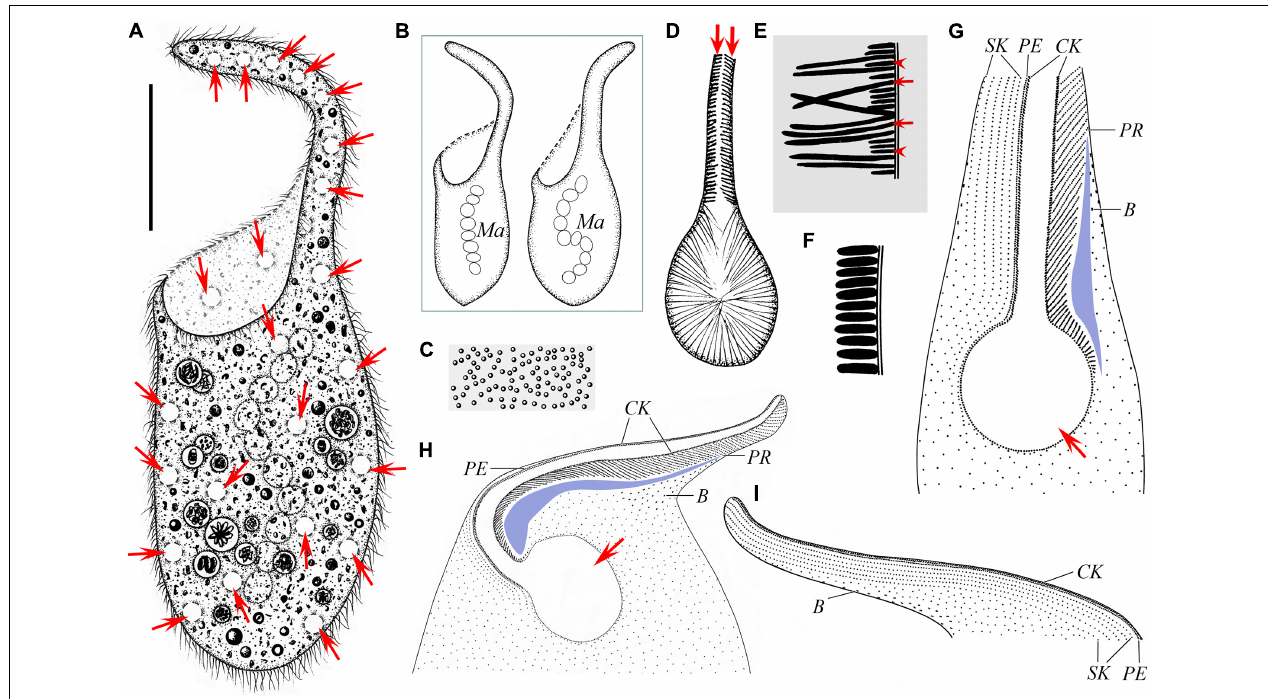
FIGURE 2 | Schematic drawings of Paradileptus elephantinus from life (A–F) and after protargol staining (G–I) . (A) Ventral view of a typical individual; arrows mark the contractile vacuoles. (B) Two individuals to show the different body shapes and distribution of macronuclear nodules. (C) Cortical granules underneath the pellicle. (D) Detail of oral apparatus, showing the oral opening, the basket supported by fibers, and the rod-shaped type II extrusomes (arrows) attached to the proboscis oral bulge. (E) Schematic drawing of a tangential optical section of the proboscis; arrows mark the elongated rod-shaped type I extrusomes; arrowheads indicate the short rod-shaped type II extrusomes. (F) Schematic drawing of a cross-section of the cortex showing the densely arranged oblong cortical granules. (G) Detail of oral region showing the circular oral opening (arrow), glabrous area (blue block), recognizable somatic kineties, perioral kinety, circumoral kinety, dorsal brush, and obliquely oriented preoral kineties. (H,I) Ciliary pattern in ventral view (H) and dorsal view (I) of anterior body portion of the same individual; arrow in panel (H) marks the oral opening. B, dorsal brush; CK, circumoral kinety; Ma, macronucleus; PE, perioral kinety; PR, preoral kineties; SK, somatic kineties. Scale bar = 70 µ m (A)